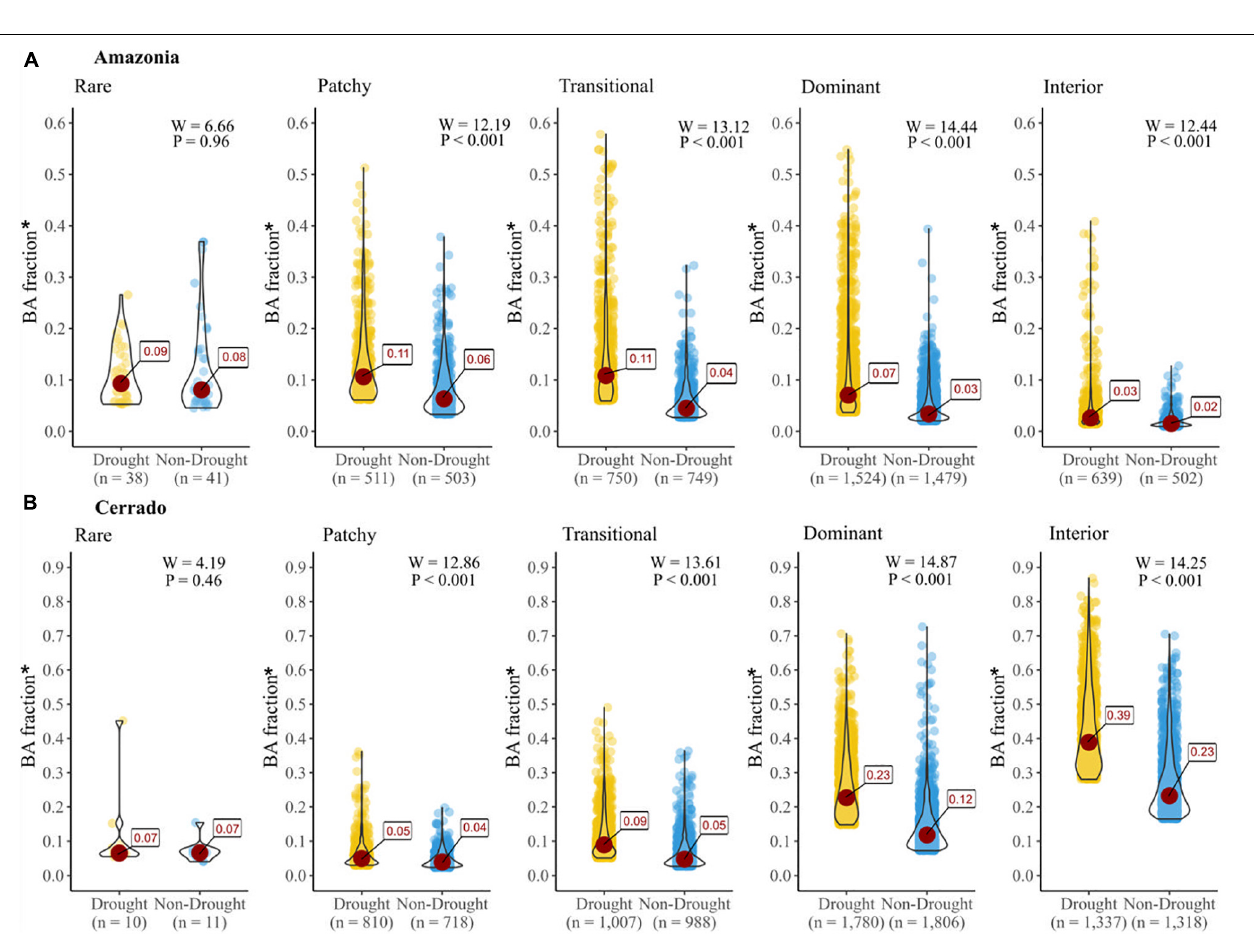
FIGURE 4 | Average BA fraction inside native vegetation* fragments for drought (yellow) and non-drought (blue) years in the Amazonia (A) and Cerrado (B) . The red dot in each violin plot is the median value. The Wilcoxon signed-rank test (W) to assess the difference between the two pairs and its p -value are shown for each pair in the figure. *Amazonia include only BA fraction within MapBiomas Forest land cover category; for Cerrado it includes BA fraction within Forest, Savannas and Natural Grasslands land cover